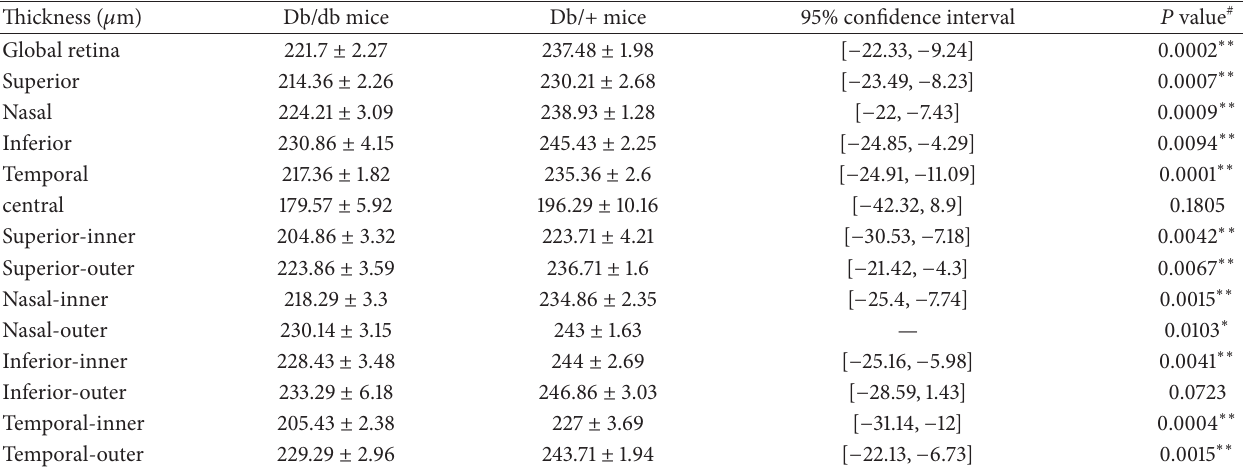
Table 1: Retinal thickness from OCT in diabetic and nondiabetic mice at 28